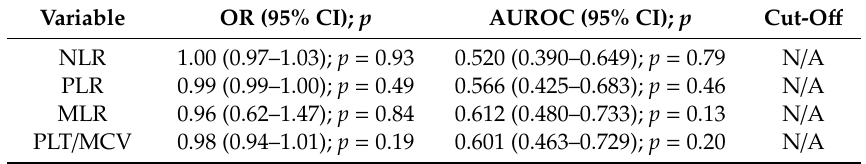
Table 6. Mortality prediction in patients with septic shock by investigated indices in bivariate analyses. Variable OR (95% CI); p AUROC (95% CI); p Cut-O ff